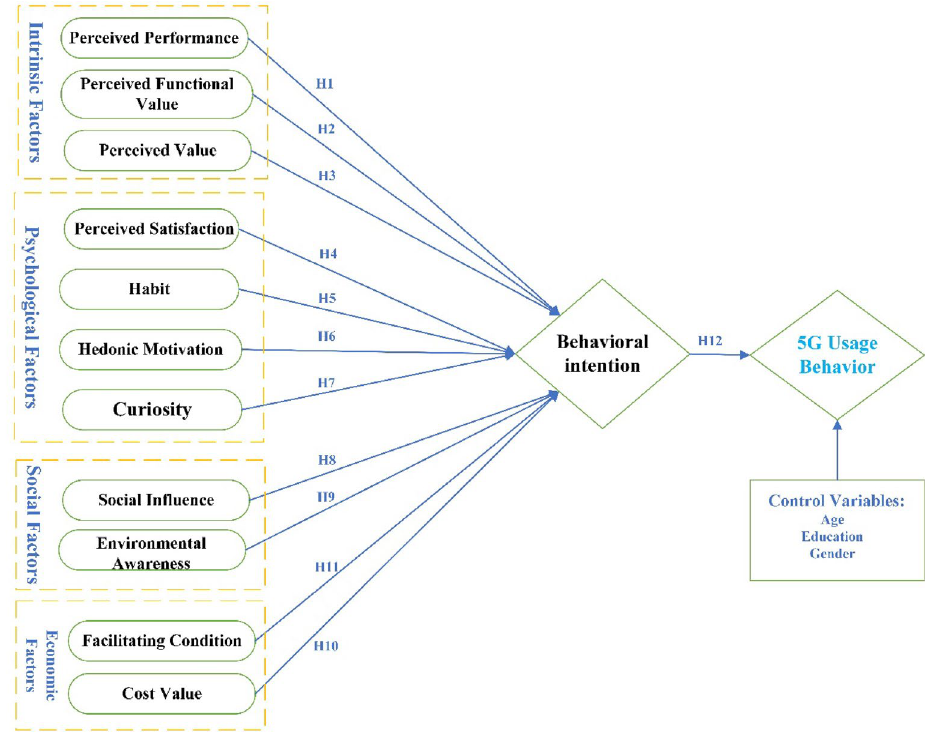
Figure 1. Conceptual